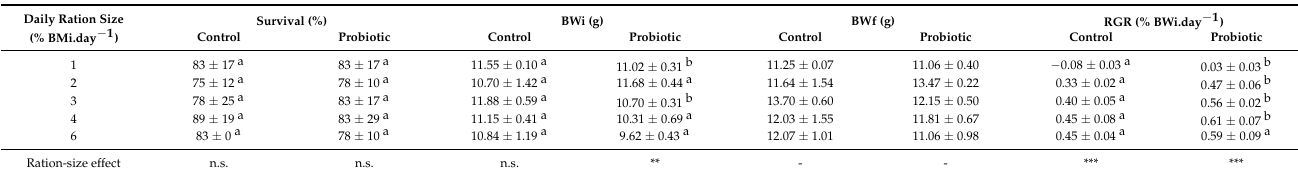
Table 3. Survival, body-size and growth of L. stylirostris per diet group at each ration size. Mean ± SD. For each parameter, different letters within the same raw indicate significant differences between diets within each ration size (Mann–Whitney test, p < 0.05). Ration-size effects assessed by Kruskal–Wallis test.